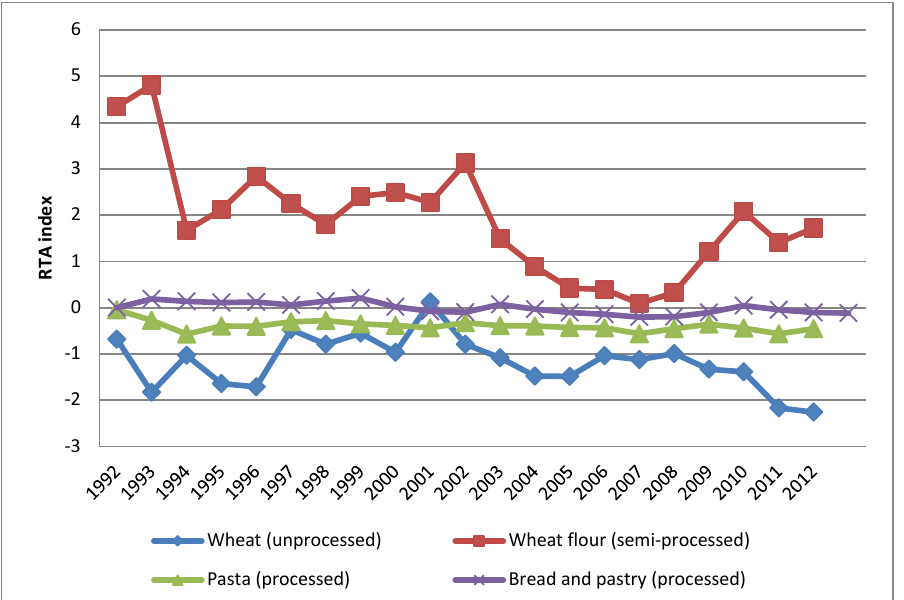
FIGURE 2: Trends in the RTA index values for unprocessed, semi-processed and processed wheat in South Africa Source: United Nations Comtrade database